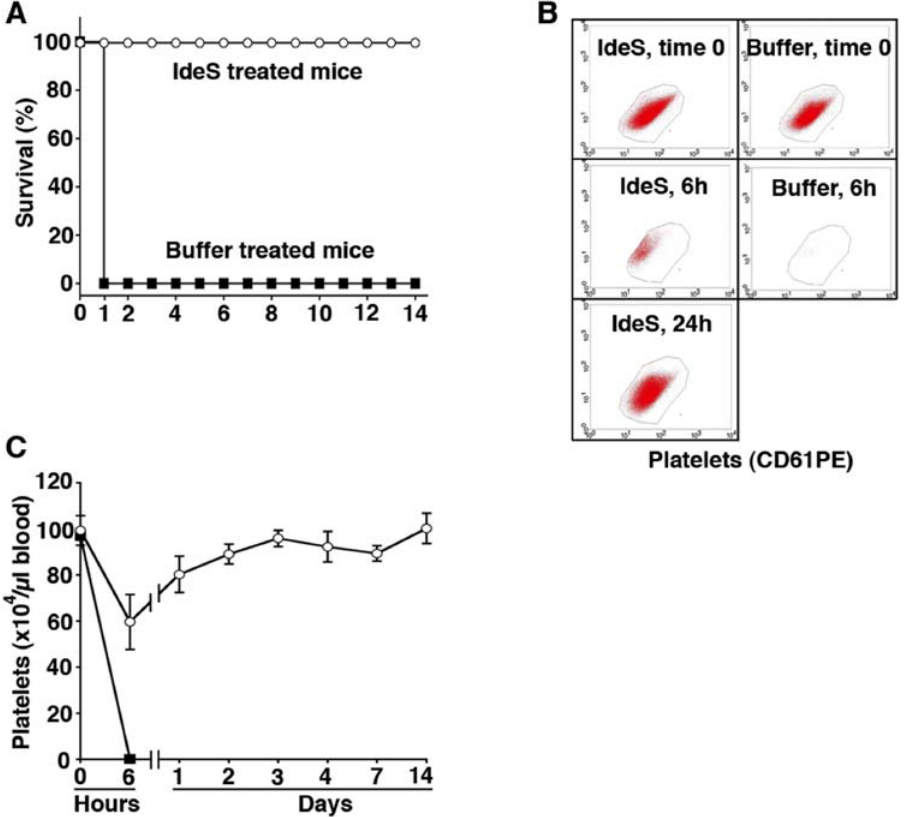
Figure 4. IdeS cures mice from lethal IgG-induced thrombocytopenia. ( A ) Fourteen BALB/C mice were injected i.p. with a lethal dose of purified polyclonal rabbit IgG antibodies (1 mg IgG/ mouse, diluted in 0.25 ml PBS) raised against mouse platelets. Thirty minutes later, seven mice were treated i.p. with 0.5 mg IdeS in 0.25 ml PBS and seven with 0.25 ml PBS alone. In another experiment, twelve Balb/c mice were injected i.p. with the lethal dose of IgG. After thirty minutes, six mice were given 0.5 mg IdeS in 0.25 ml PBS, and six were given 0.25 ml PBS alone. In this case, the injections were given i.v. The thirteen IdeS treated mice ( # ) all survived, whereas the thirteen PBS treated mice ( & ) all died within 24 hours. ( B ) Blood samples from the twelve mice injected with the lethal dose of purified rabbit IgG and treated i.v. with IdeS or PBS alone (six mice in each group), were analyzed using flow cytometry of the platelet population. Samples from two representative animals, one injected with IdeS and one with PBS, are shown. ( C ) The number of platelets in the blood samples from the twelve animals treated i.v. was counted manually; six treated with IdeS ( # ) and six with PBS ( & ). Error bars indicate 6 SEM.